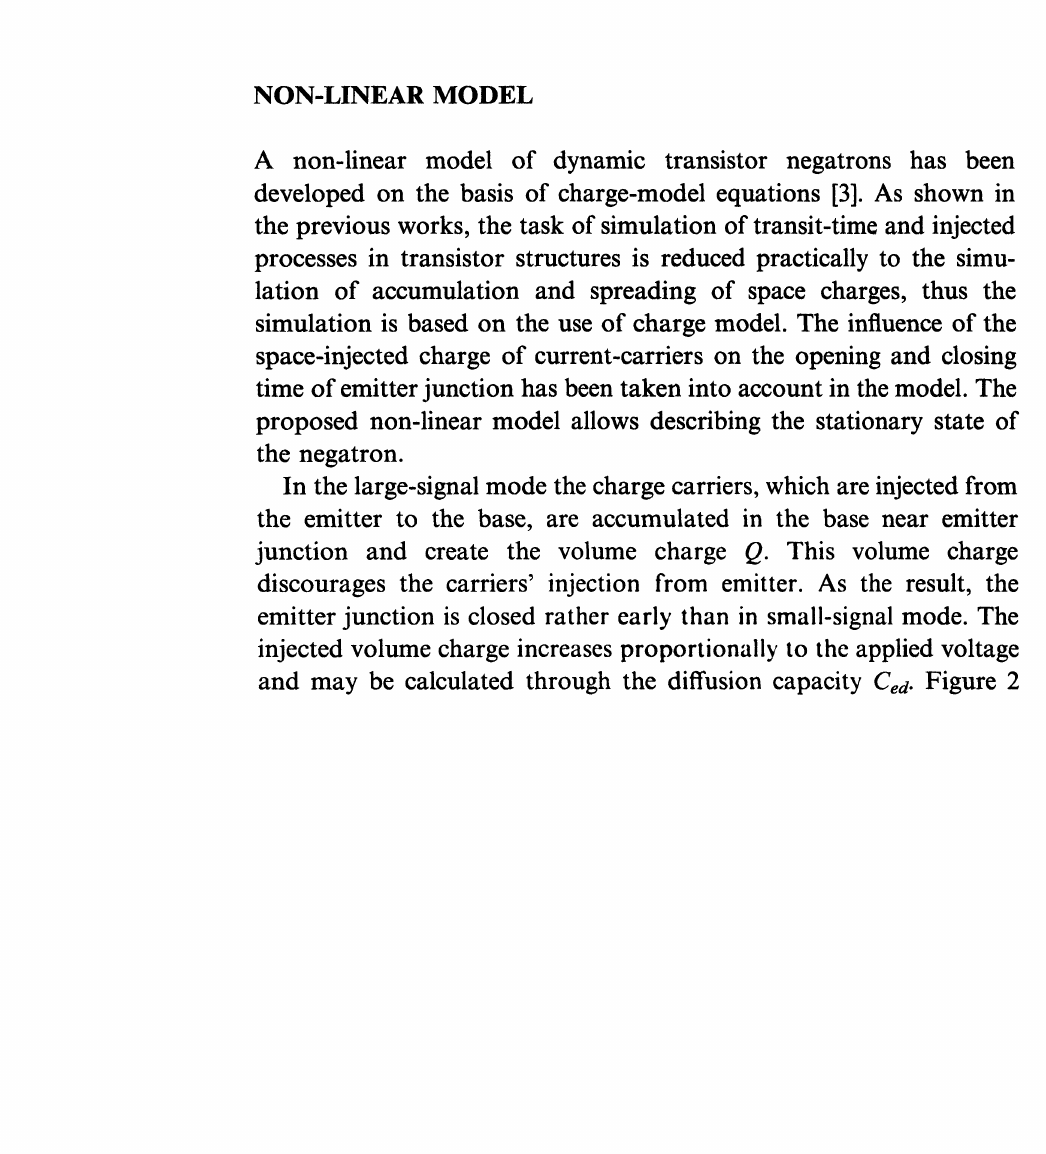
FIGURE lc Time dependence of alternate current and voltage in dynamic